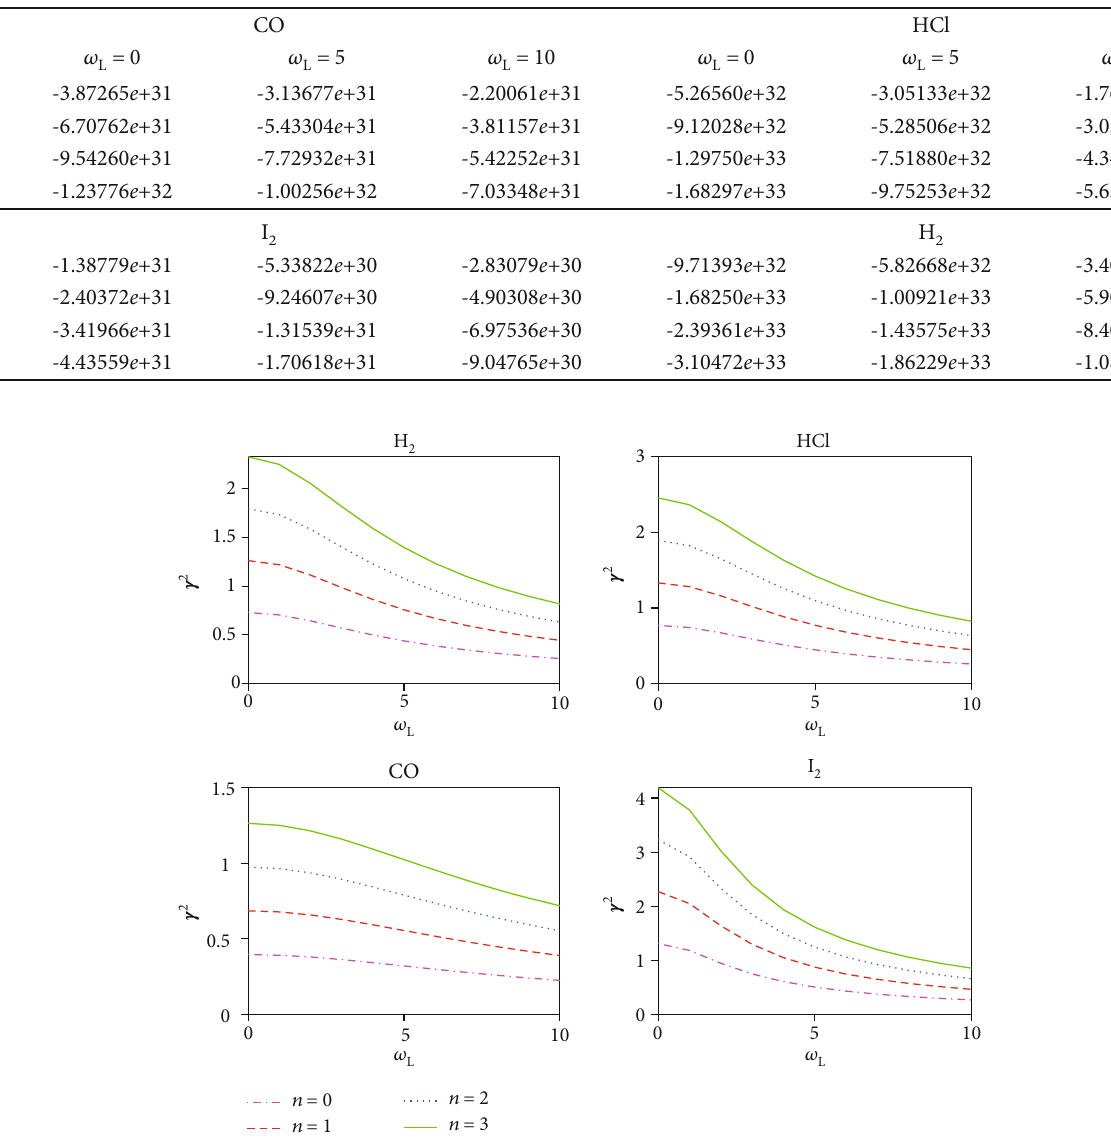
for various numbers of states n with L